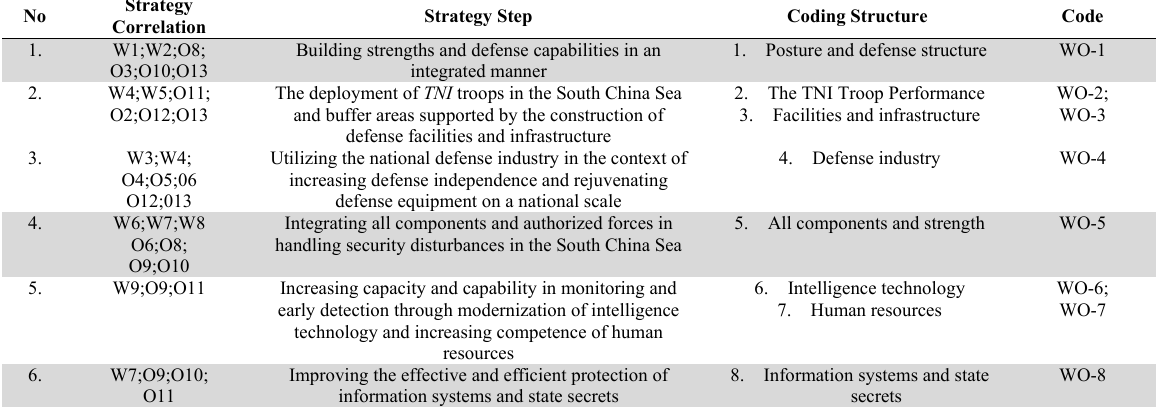
Strategy and Coding of RMA Development towards Competitive